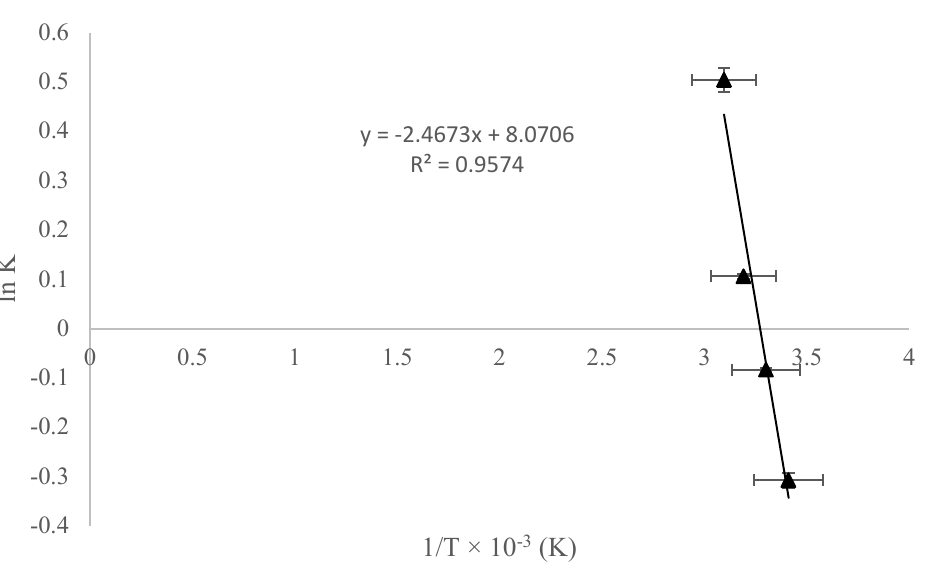
Figure 8. Thermodynamic study of Cr(VI) adsorption by CMPVL. Table 4. Thermodynamic parameters for Cr (VI) biosorption on CMPVL. Parameters Values ∆ H ◦ (J/mol K) − 20.51 ∆ S ◦ (J/mol